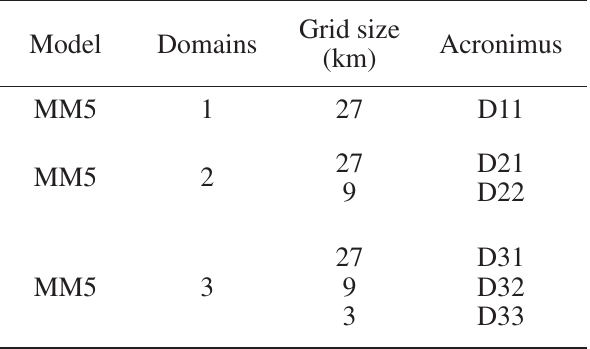
Table I. The model simulation performed using dif- ferent nested levels. D11 for model simulation using one domain only. D21,2 for model simulation using two domains. D31,2,3 for model simulation using three